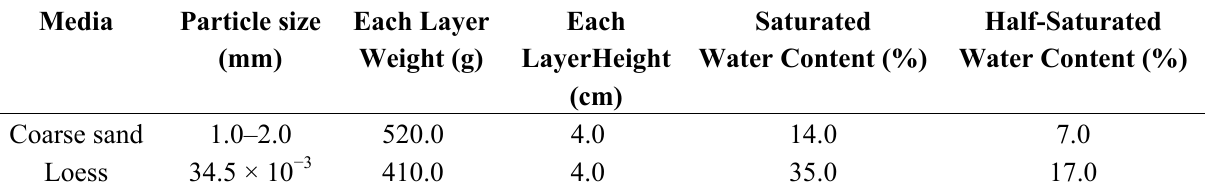
Table 1. Physical properties of experimental porous